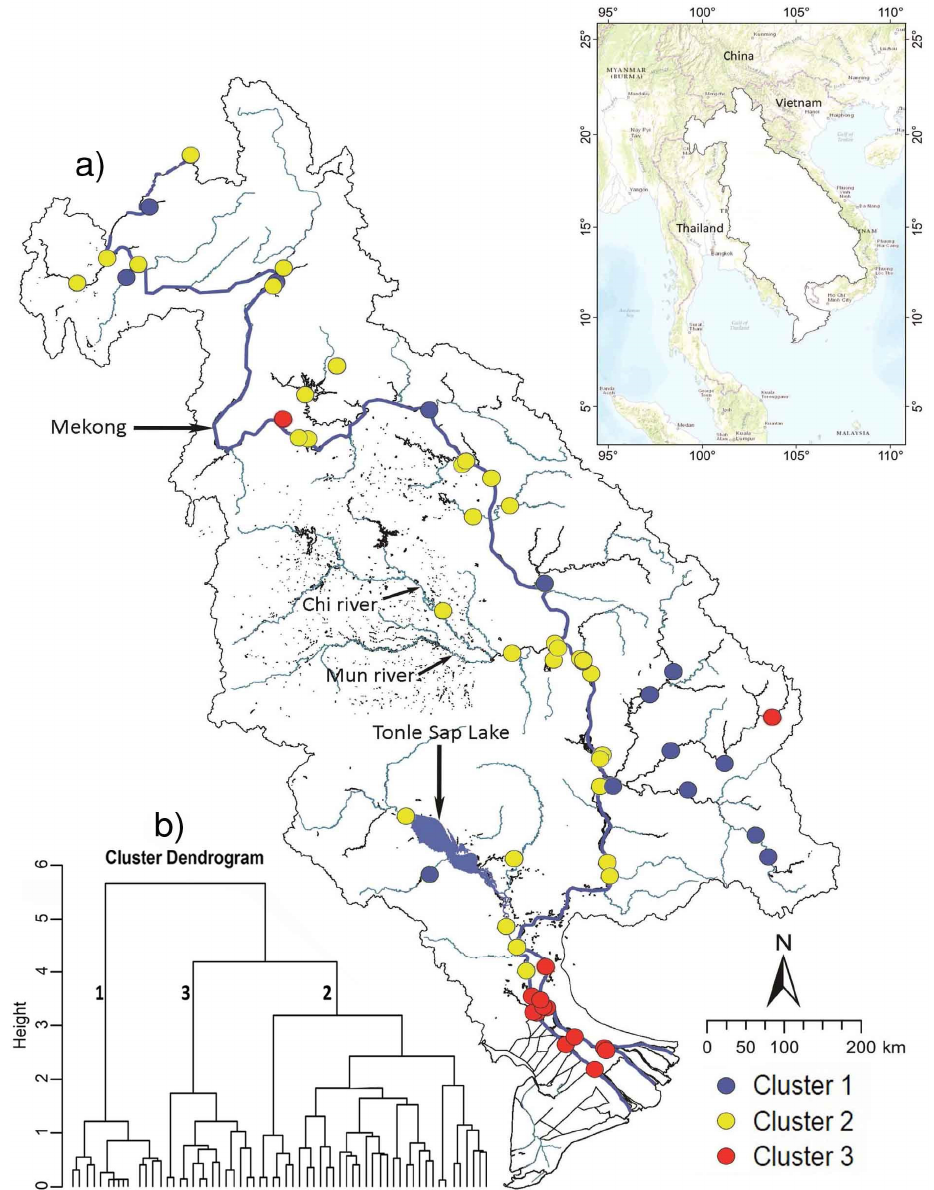
Figure 1. The sampling sites belonging to each cluster projected on the map ( a ) and the dendrogram showing the three distinct clusters using mollusc data collected from 63 sampling sites from the Lower Mekong Basin ( b ). See Results (Section 3) for details.